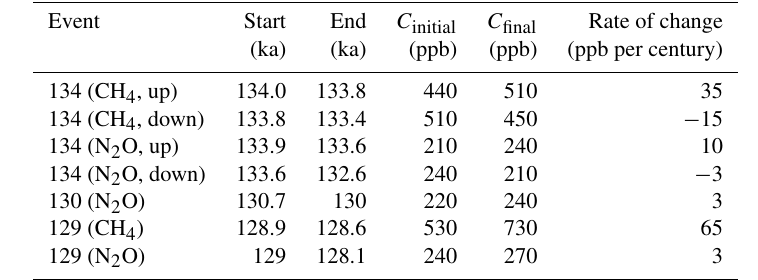
Table 1. Characteristics of the events observed at ∼ 134, ∼ 129, and ∼ 130ka. The indications “up” and “down” in the first column refer to the ascending and descending limbs of the 134ka event, respectively. The columns “start” and “end” indicate the starting and end points of the events (rounded to the hundred). The columns C initial and C final indicate the concentrations (rounded to the 10) in the years preceding and following the events, respectively. The rates of change are average values over the time period comprised between the start and end points of the events. Rates of change are calculated from spline approximations (cut-off period: 200 years) computed according to Enting (1987) with the same routine as Beck et al.